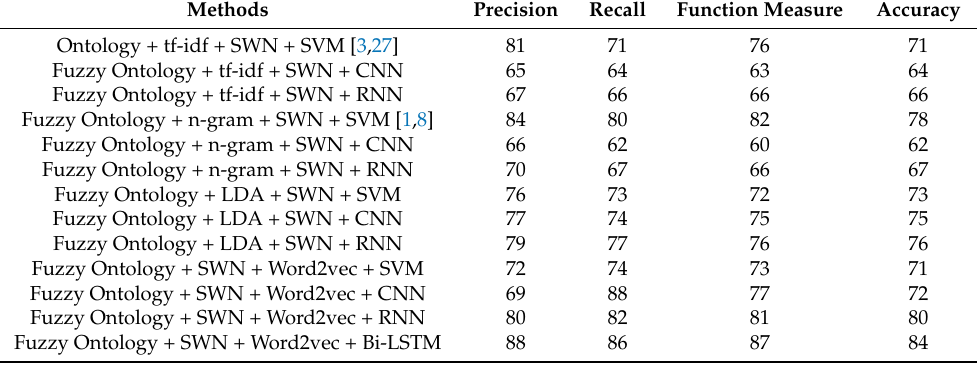
Table 4. Sentiment classification performance of the different methods.